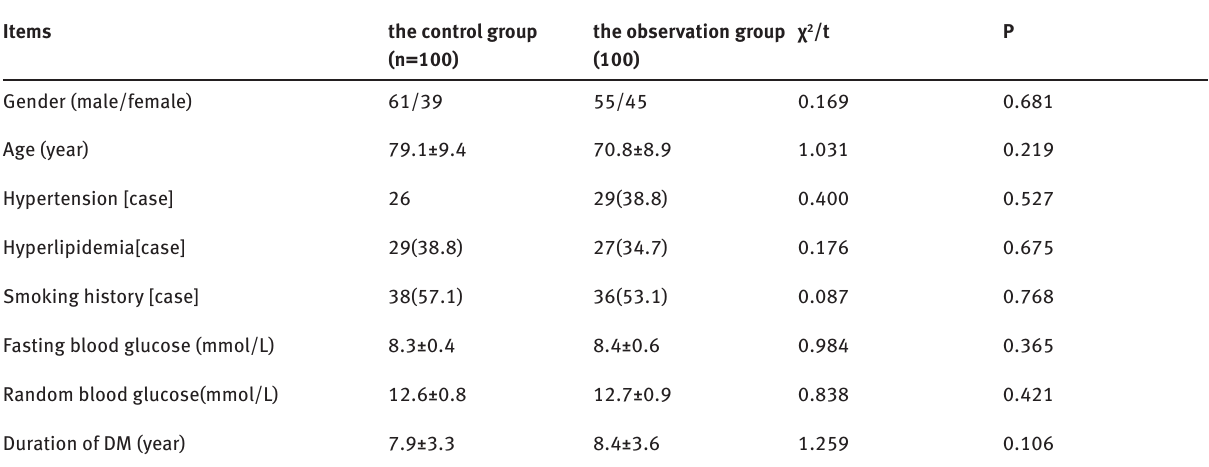
Table 1: Basic clinical data of patients in both the groups